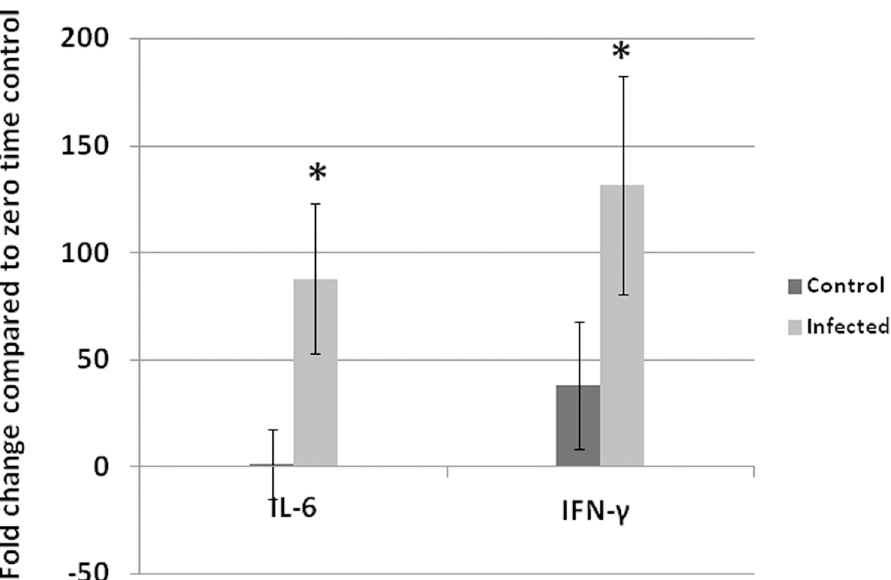
Fig 5. Fold change of IL-6 and IFN- γ in tendons at 14 dpi. Both IL-6 and IFN- γ were significantly elevated at 14 dpi in tendons of infected birds compared with non-infected control. Analyses were performed in duplicate (Five turkeys/group at each time point) and values are mean ± 3SD. * Differences between infected group and non-infected groups within the same organ are significant (P < 0.05).